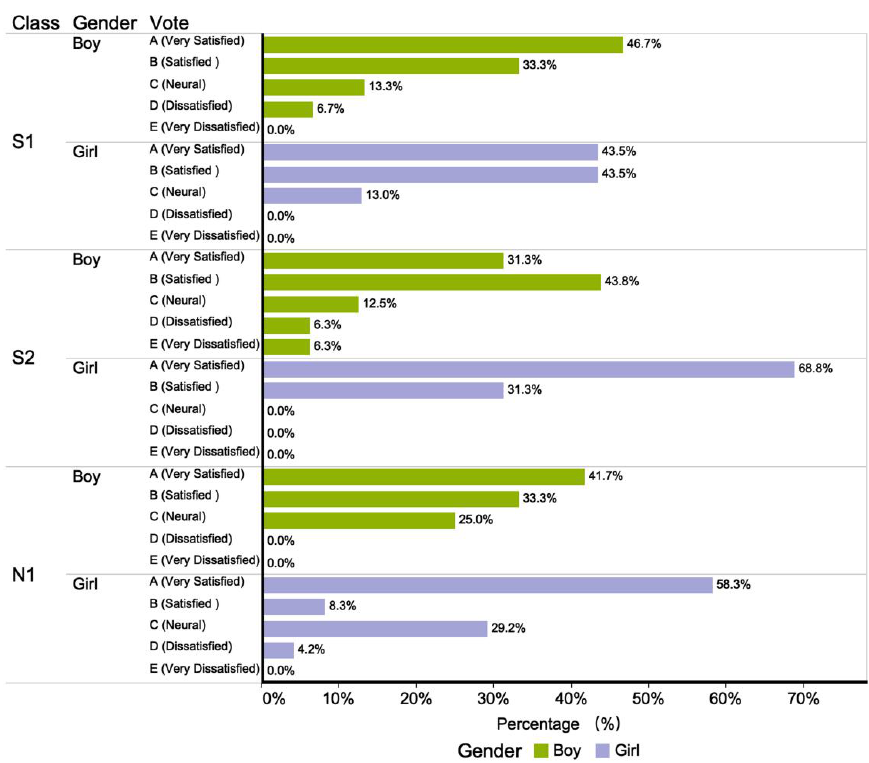
Figure 8. The satisfied votes of boys and girls in the three classrooms. 175